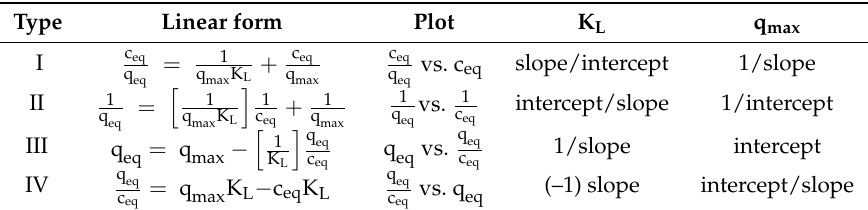
Table 3. Linear forms of the Langmuir isotherm (according to